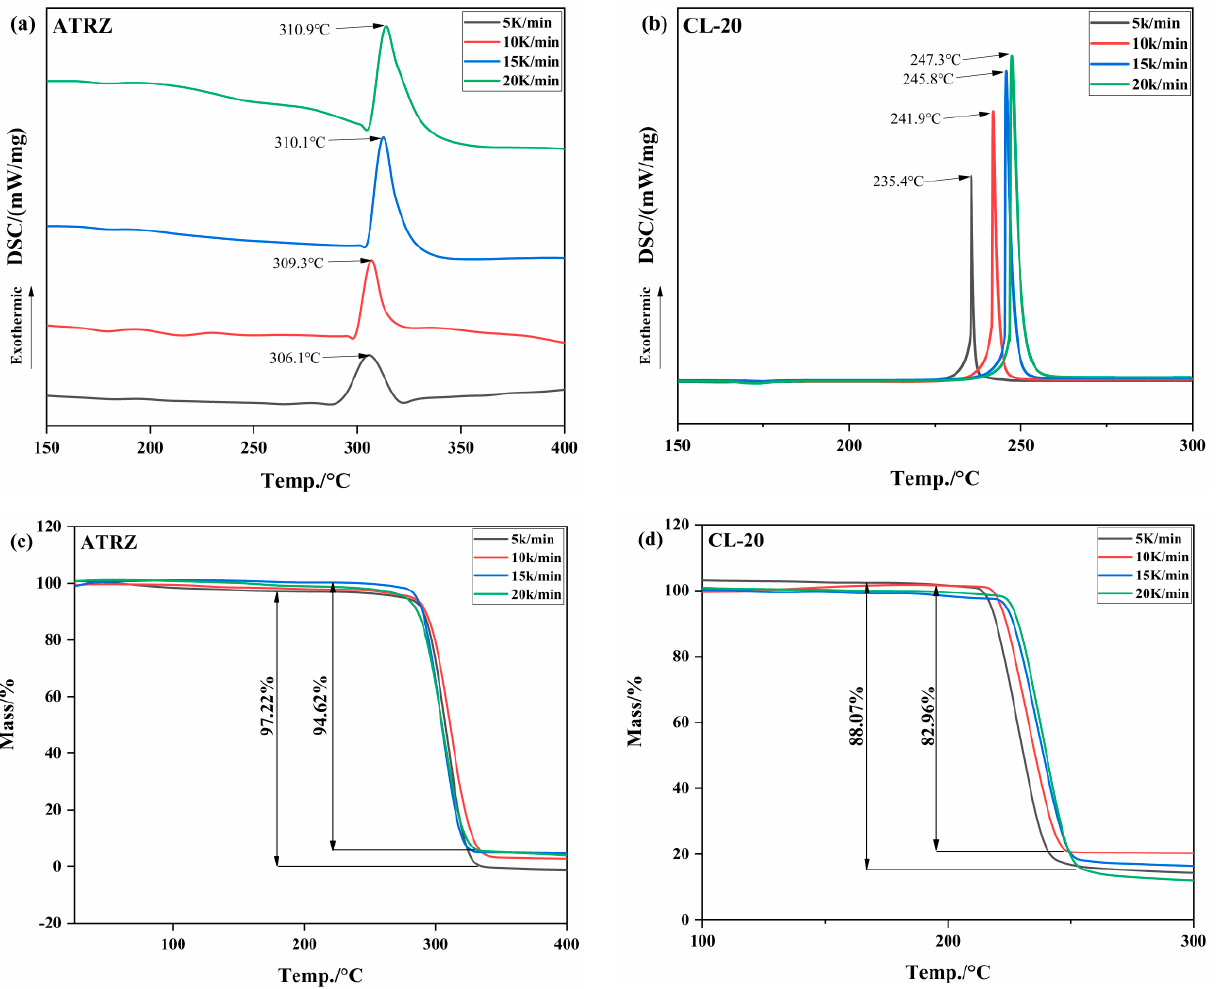
Figure 4. TG–DSC curves of ATRZ and CL-20 at different heating rates. DSC curve of ATRZ ( a ), DSC curve of CL-20 ( b ), TG curve of ATRZ ( c ) and TG curve of CL-20 ( d ). The kinetic parameters of ATRZ and Cl-20 at T p were fitted and calculated by Kissinger’s Equation (1) [18].